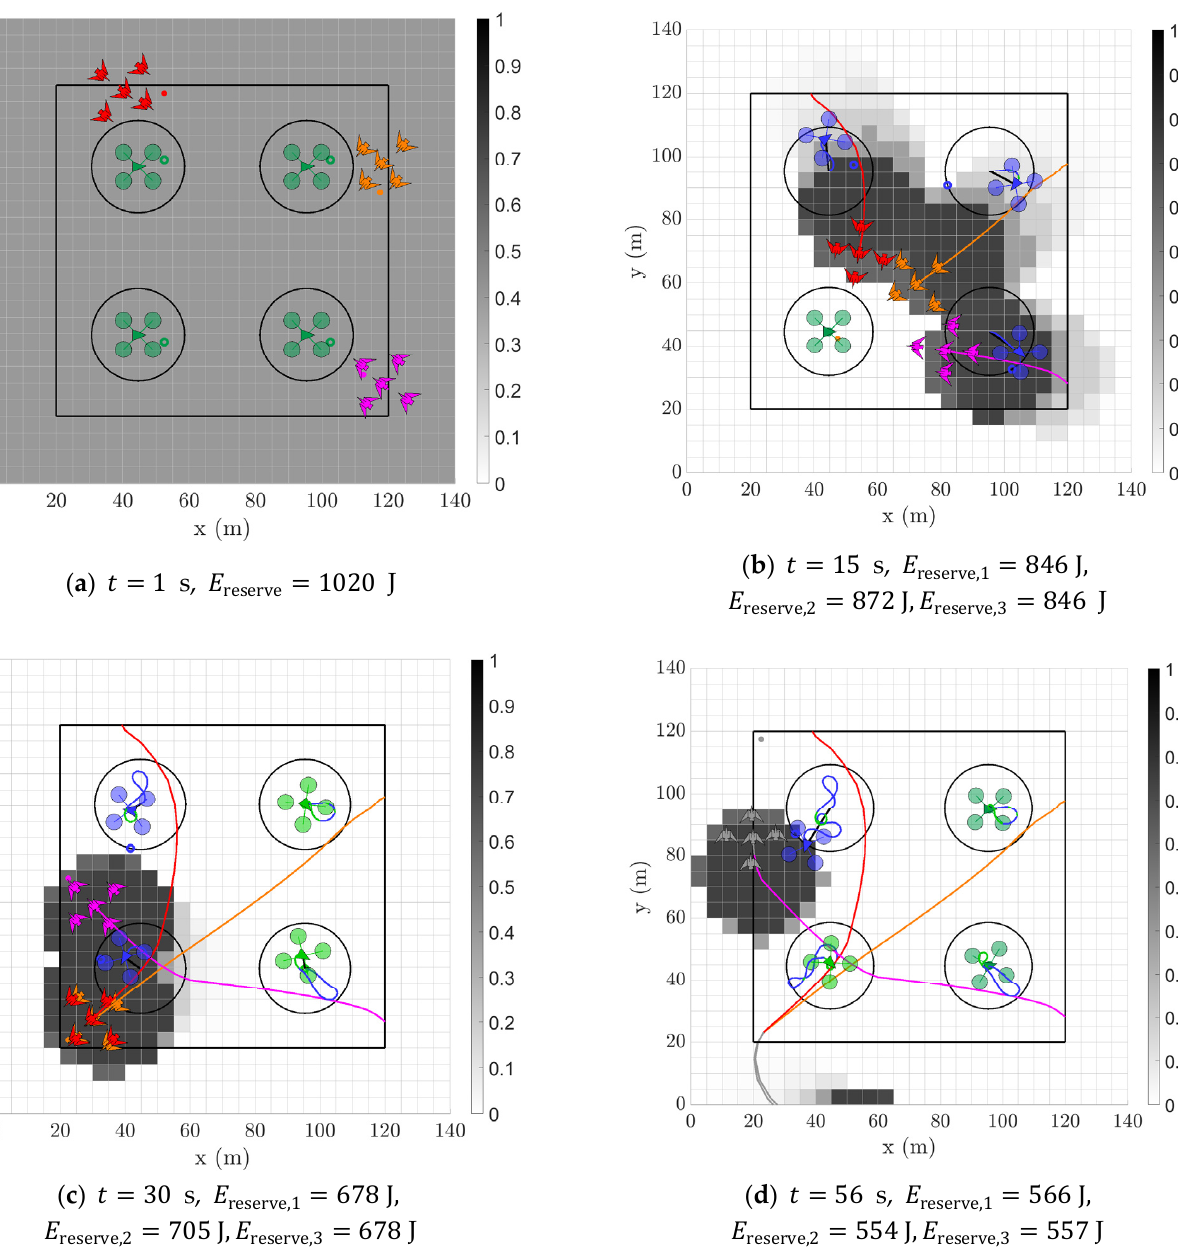
Figure A5. Snapshots of a sample triple target simulation with the following configuration: n = 4 agents, R T = 14 m, v max = 12 m/s. Simulation begins in ( a ) with each target in the flock at the full energy reserve of 1020 J, all agentjer I u s undeployed in their Home state, and each cell in the probability map initialised with the same value. As the simulation progresses from ( b , c ), both target flocks seek to find grid cells of maximum interest indicated by their respective red ( Flock 1 ), magenta ( Flock 2 ) and orange ( Flock 3 ) dots but are repelled by nearby deployed agents, shown in their Chase state, while agents that were deployed but no longer in range are shown in their Return state. Simulation is completed in ( d ) with both target flocks centre (greyed out) no longer in the protected area at the same time of t = 56 s and the original energy reserve approximately halved.